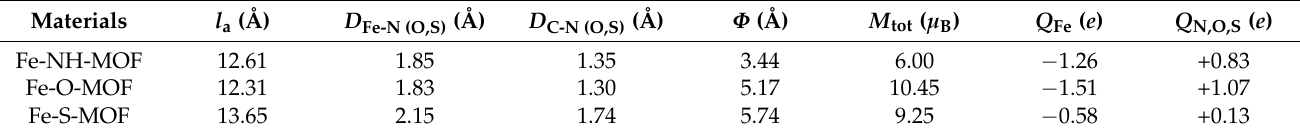
Table 1. Calculated geometric parameters (lattice constants ( l a ), the bond length of Fe-N (O, S) ( D Fe-